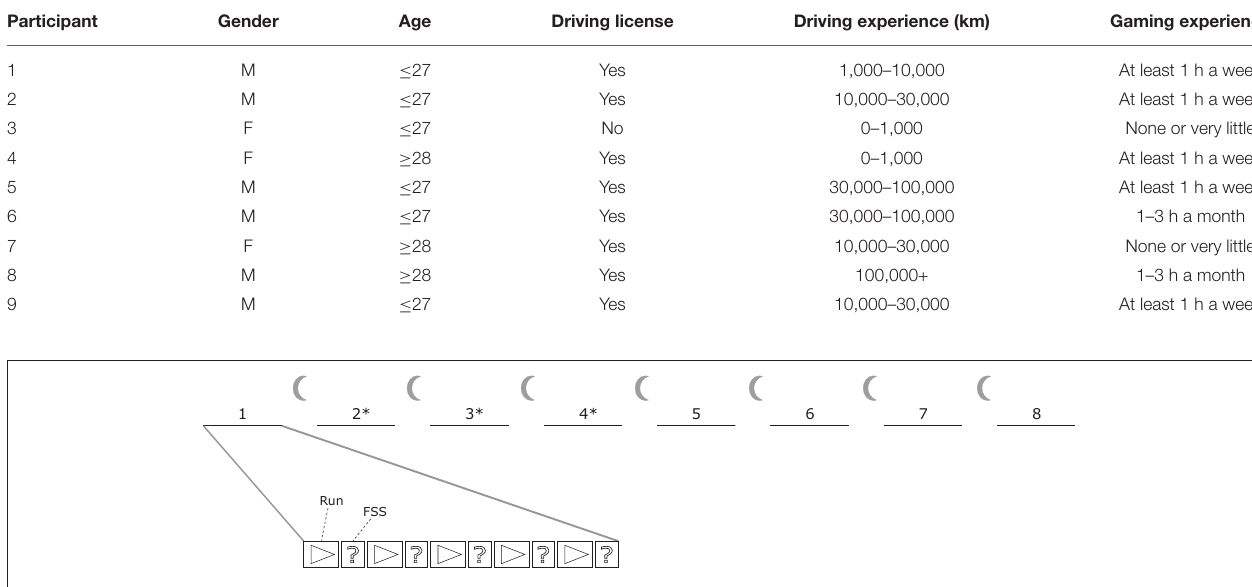
FIGURE 2 | The game was played in eight sessions on eight different days. In sessions 1 and 5–8, physiological signals were recorded during task performance; in sessions 2–4(*) no physiology was recorded. Each session consisted of five trials (2–4 min) followed by a self-report questionnaire (FSS, Flow Short Scale) about